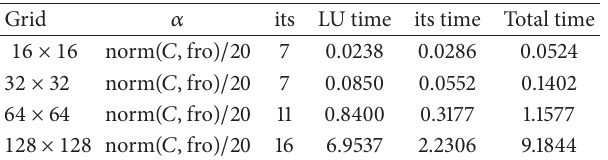
Table 5: Preconditioned GMRES(20) on Stokes problems with different grid sizes (uniform grids).